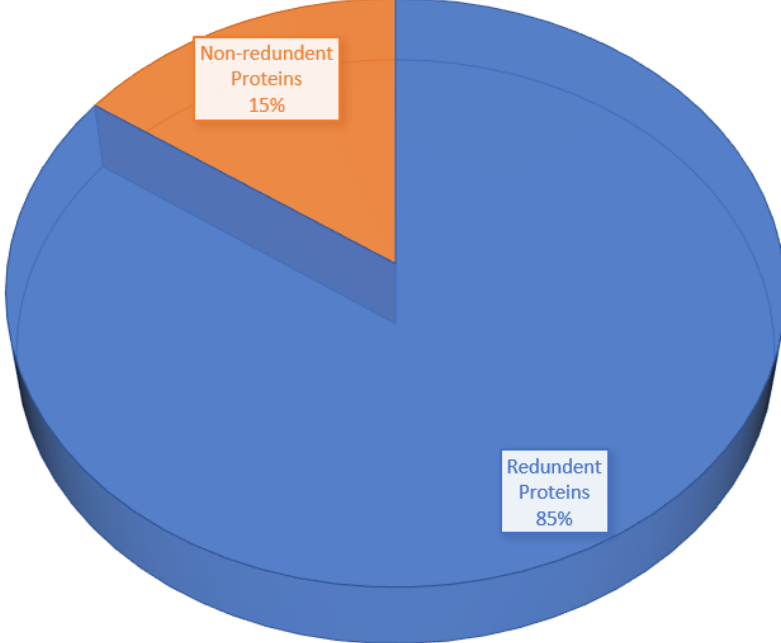
Figure 4. Pie-chart shows the percentage of redundant proteins and non-redundant proteins.